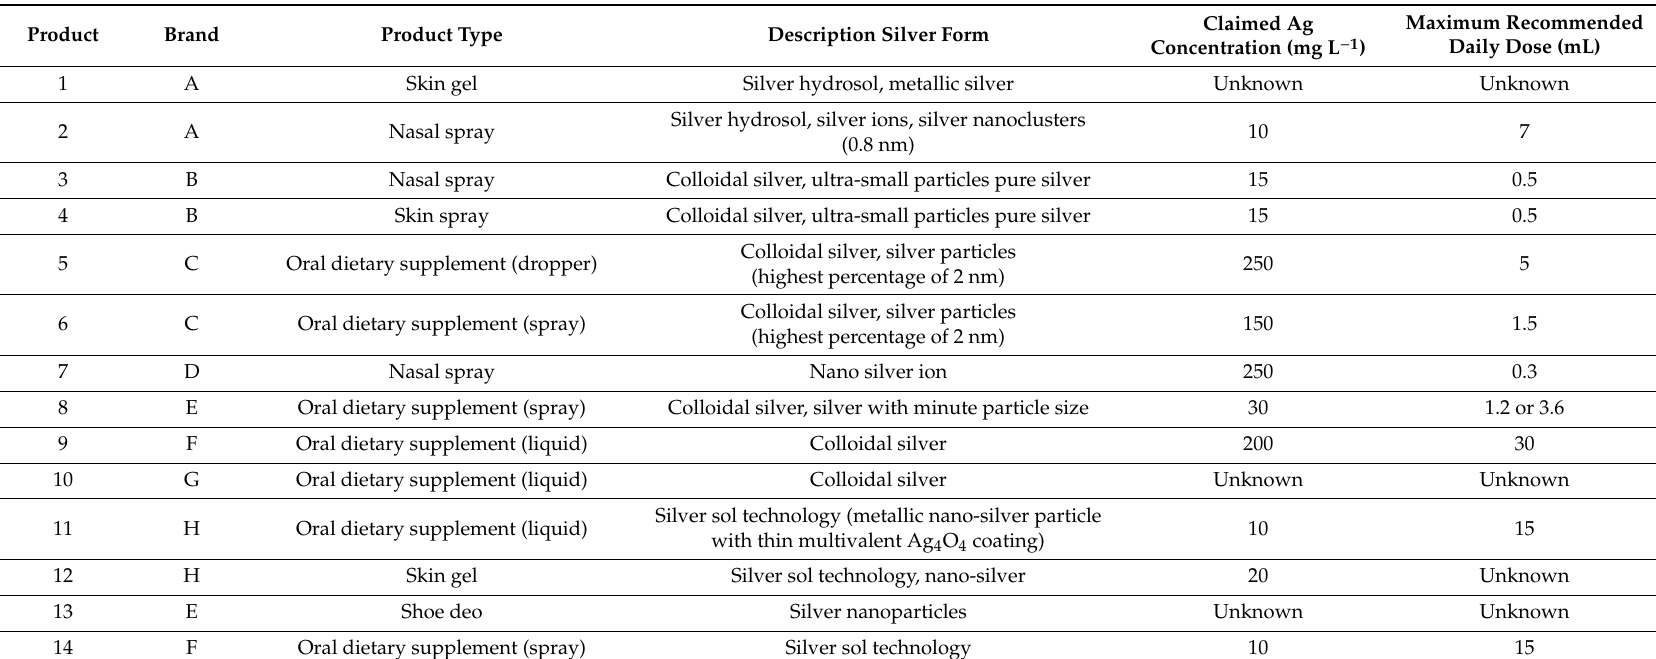
Table 1. Label information of the 14 di ff erent silver products (part